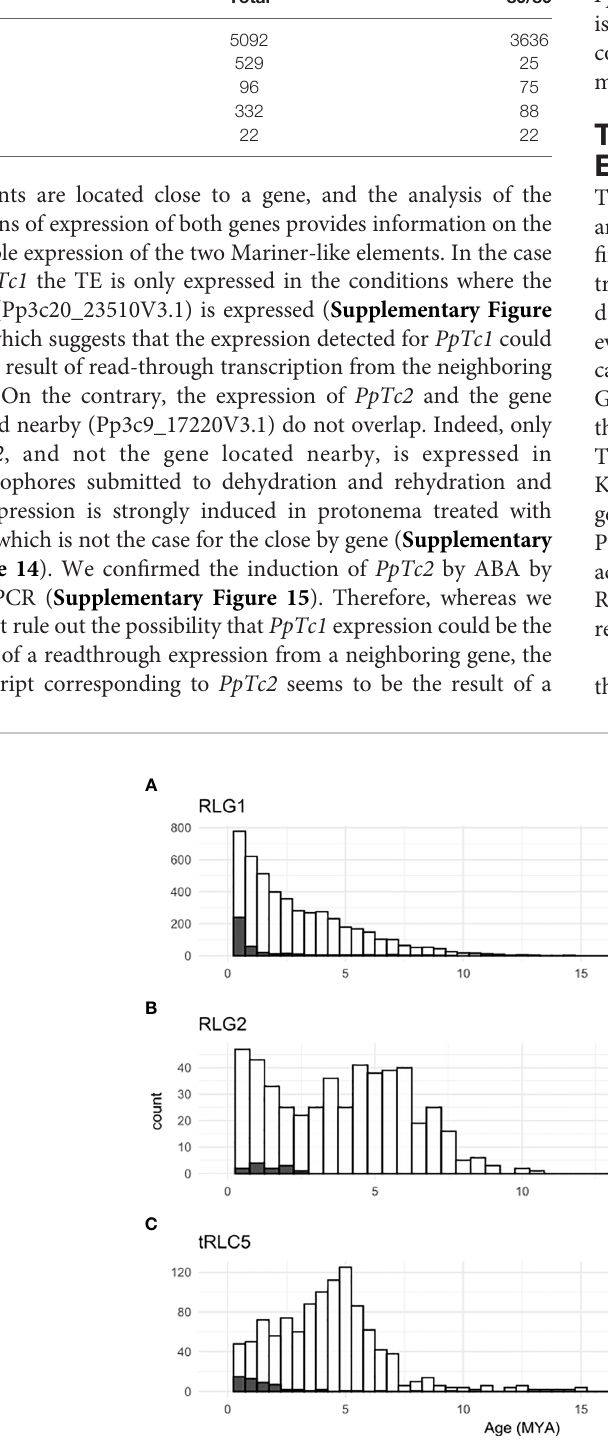
FIGURE 5 | Relative age of expressed TEs. Kimura-2-parameter distance between the two LTRs of all elements (white bars) or of elements similar to the corresponding RNA assembly, and therefore potentially expressed (black bars) belonging to the RLG1 (A) , RLG2 (B) and tRLC5 (C)